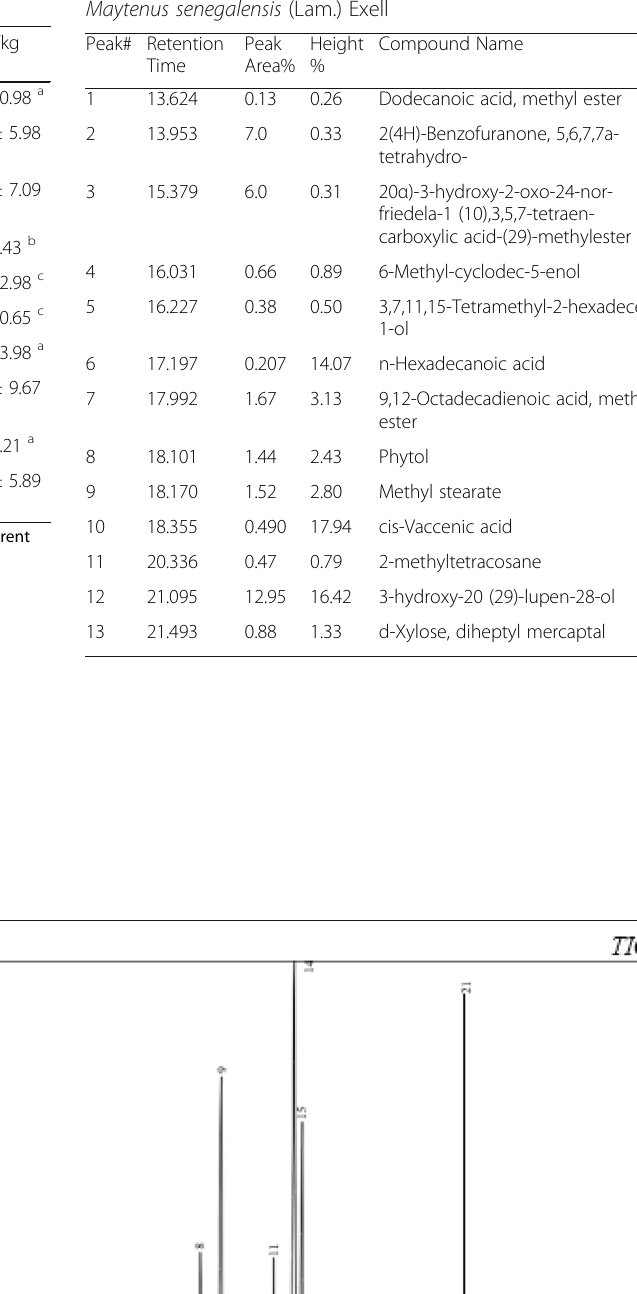
Table 6 Phyto-Components identified in the purified fraction